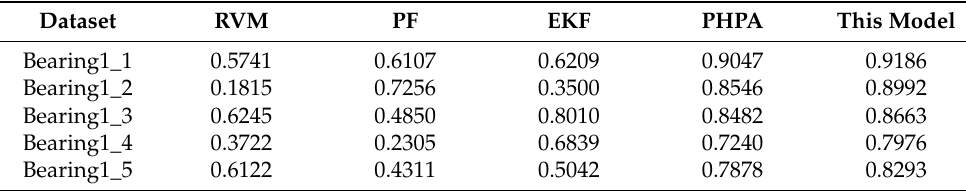
Table 3. CRA comparisons between five methods.